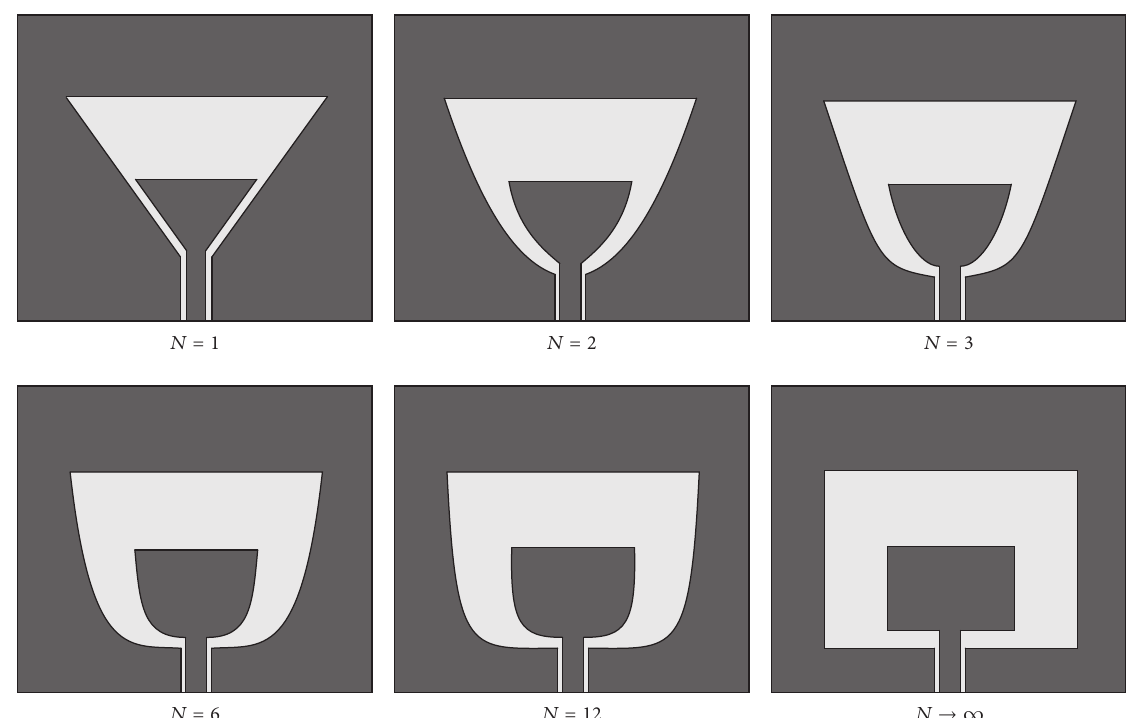
Figure 28: The CPW-fed printed binomial wide-slot antennas [93]. Dark gray upper metal face and light gray dielectric substrate.